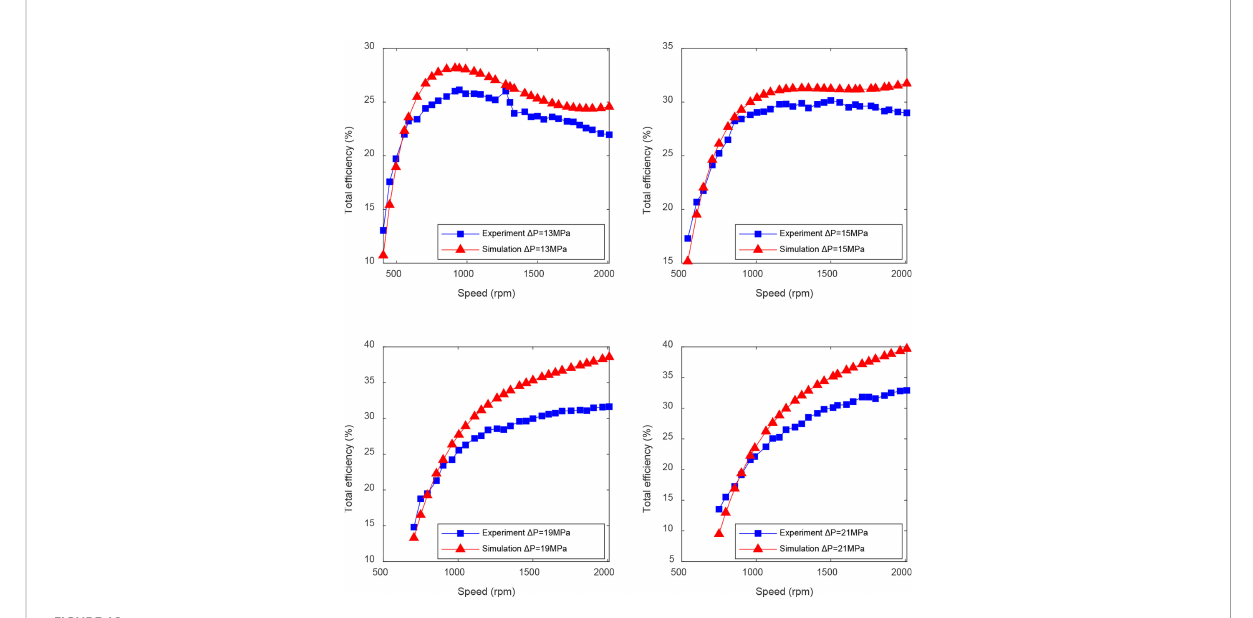
FIGURE 10 The simulation and experimental comparison of indirect method.